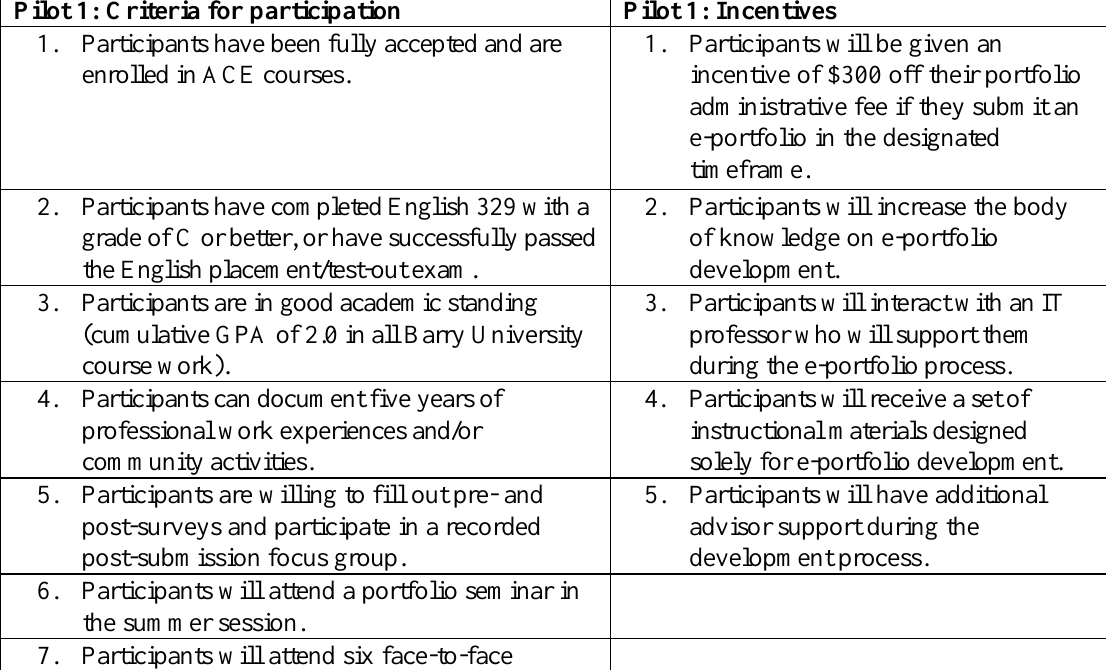
Table 1 Criteria for Participation and Incentives Pilot 1: Criteria for participation Pilot 1: